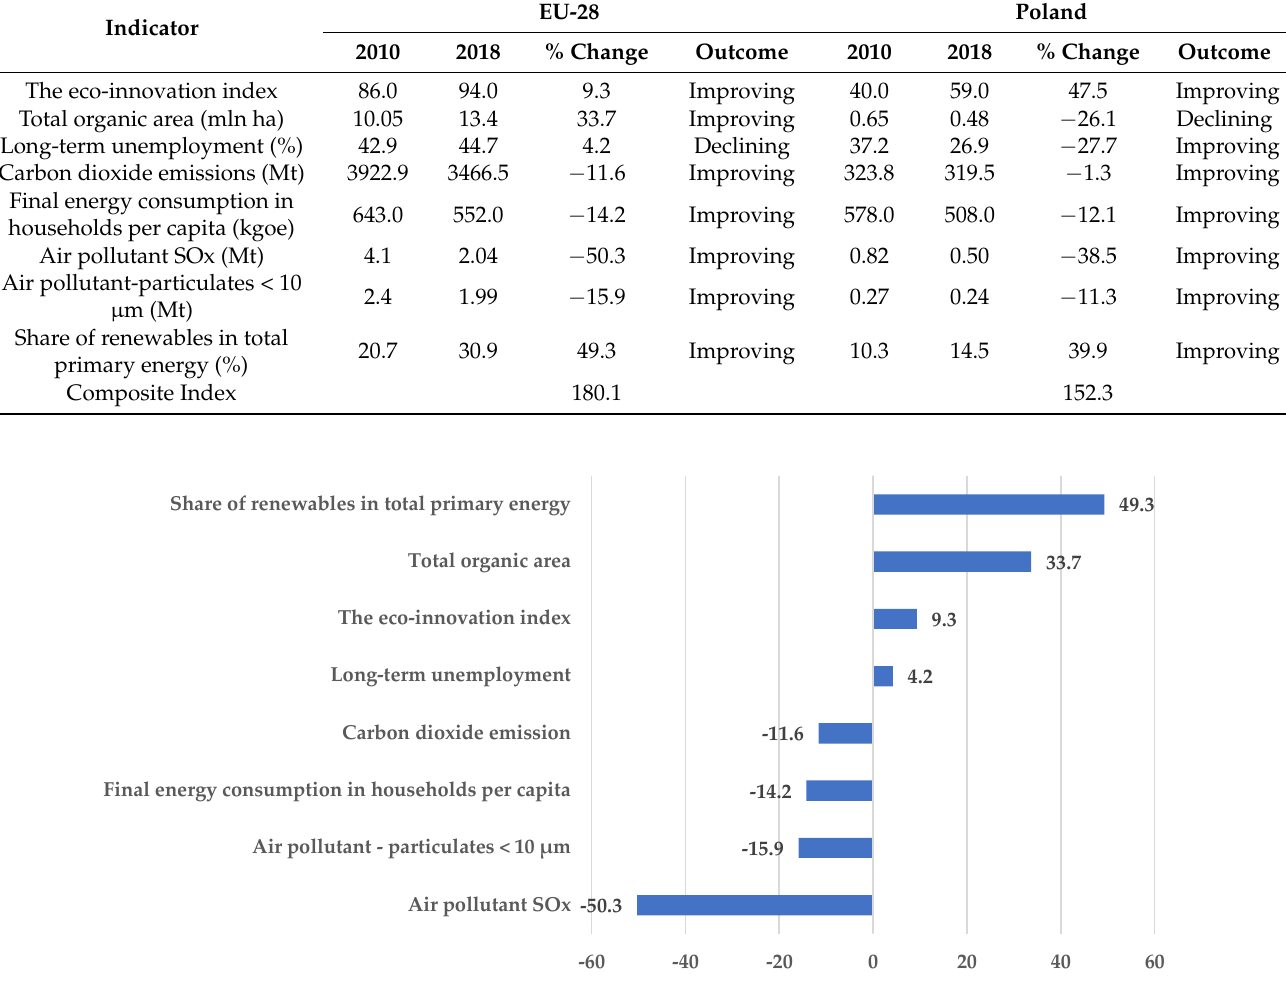
Figure 7. Net change (%) in SDG indicators, Poland, 2010–2018. Own study, based on [31].